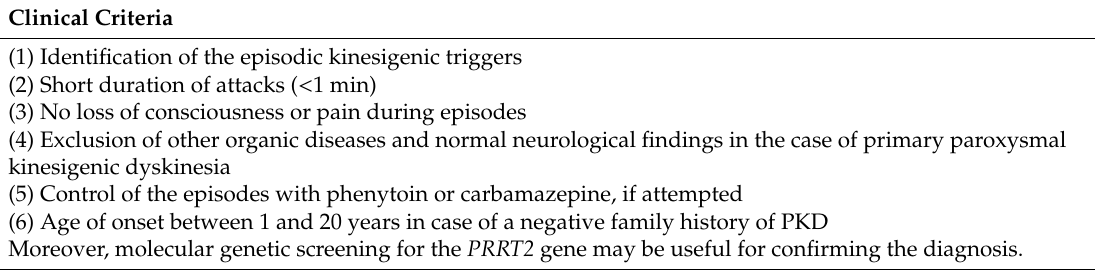
Table 1. Clinical criteria for the diagnosis of paroxysmal kinesigenic dyskinesia [3]. Clinical